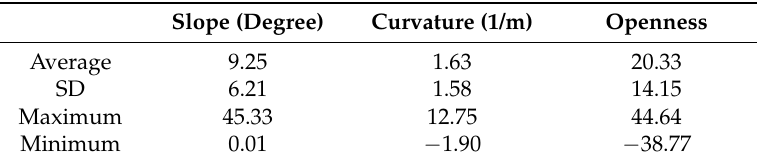
Table 2. Descriptive statistics of low wall